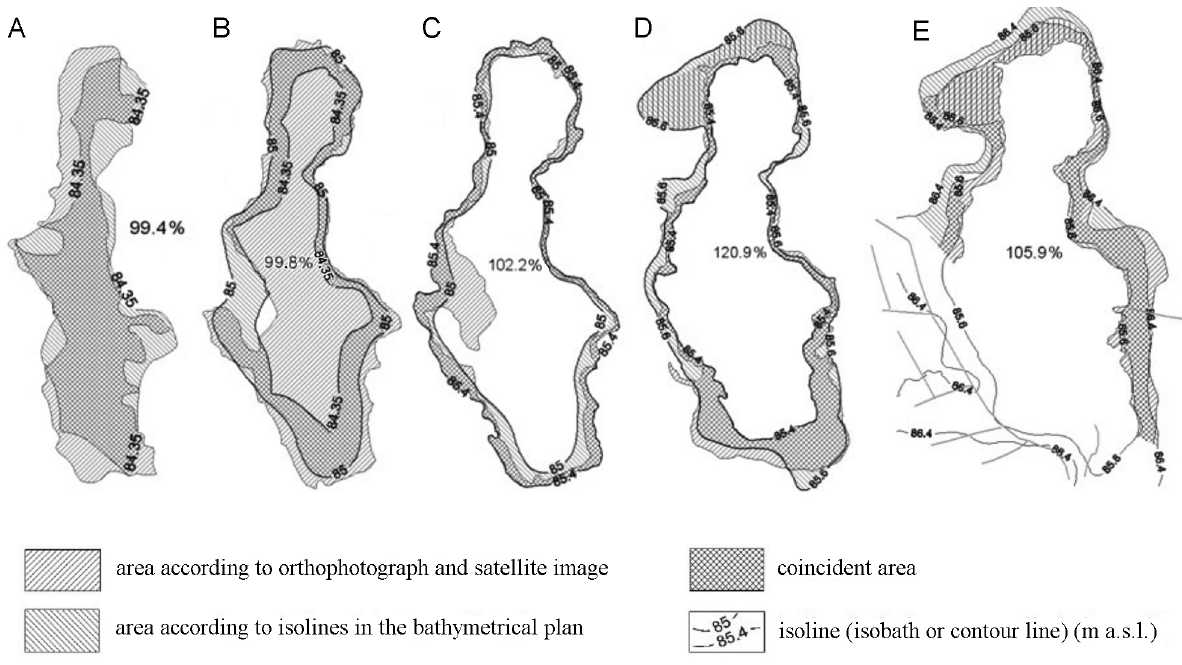
Fig. 7. Coincidence of the sub-wetland area and location in Lake Č edasas: A , open water; B , hydrophytes; C , helophytes; D , open grass vegetation; E , mire